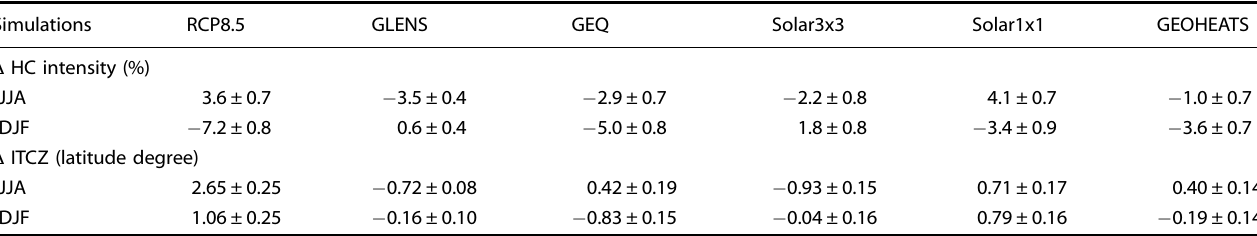
Table 3. JJA average and DJF average ensemble mean changes in winter Hadley cell intensity (%) and ITCZ shift (latitude degree) under RCP8.5, GLENS, GEQ, Solar3x3, Solar1x1 ensemble mean (2075 – 2095) and GEOHEATS ensemble means relative to the baseline ensemble mean (RCP8.5 runs during 2010 – 2030),